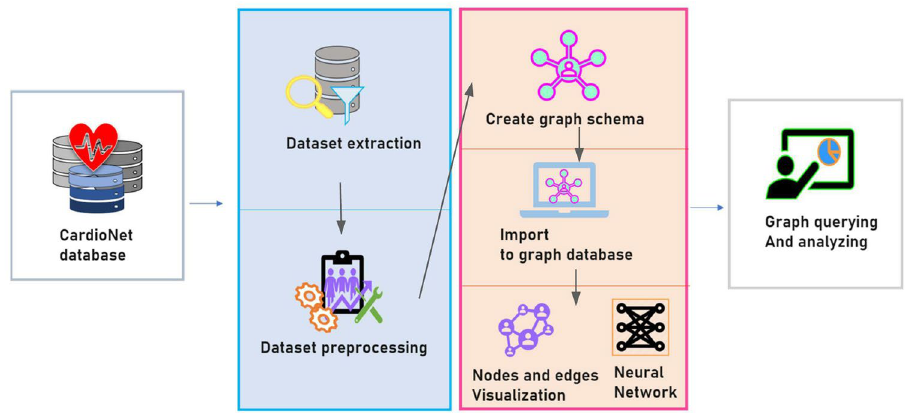
Figure 1. A pipeline for graph construction and graph neural network. The overall process was identical until the editing and manuscript step of the datasets. At this point, the graph schema production step differentiates.